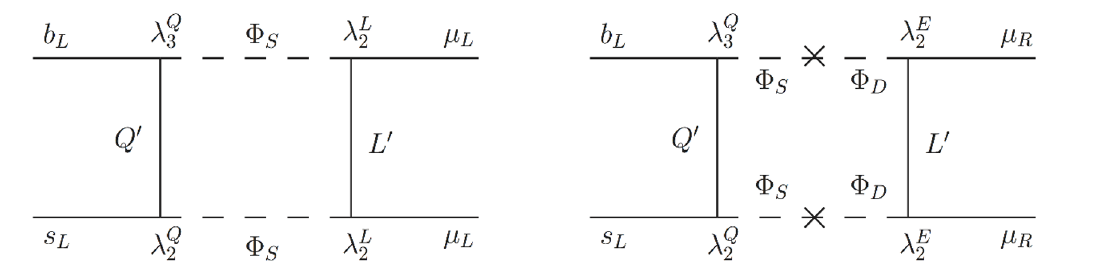
Figure 2 . Diagrams contributing to the b ! s(cid:22)(cid:22) operators C bs(cid:22)(cid:22)